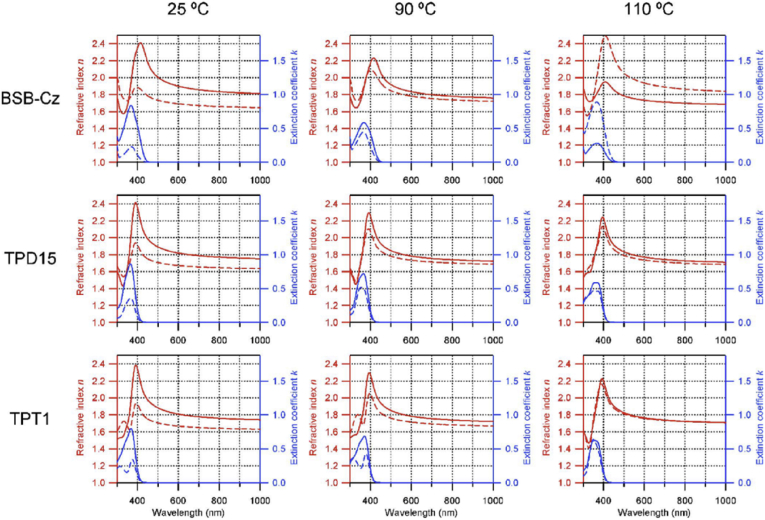
Ellipsometry on Si (100) coated with various materials: BSB-Cz (4,4′-Bis [(N-carbazole)styryl]biphenyl); TPD15 (N,N,N′,N′-tetrakis (biphenyl-4-yl) benzidine); TPT1 (N,N′-Diphenyl-N,N′-bis [4’-(N,N-diphenyl-amino)biphenyl-4-yl] benzidine) [Yokoyama and Adachi, 2010]. The plots show the variation in refractive index and extinction coefficient for different temperatures as a function of wavelength.